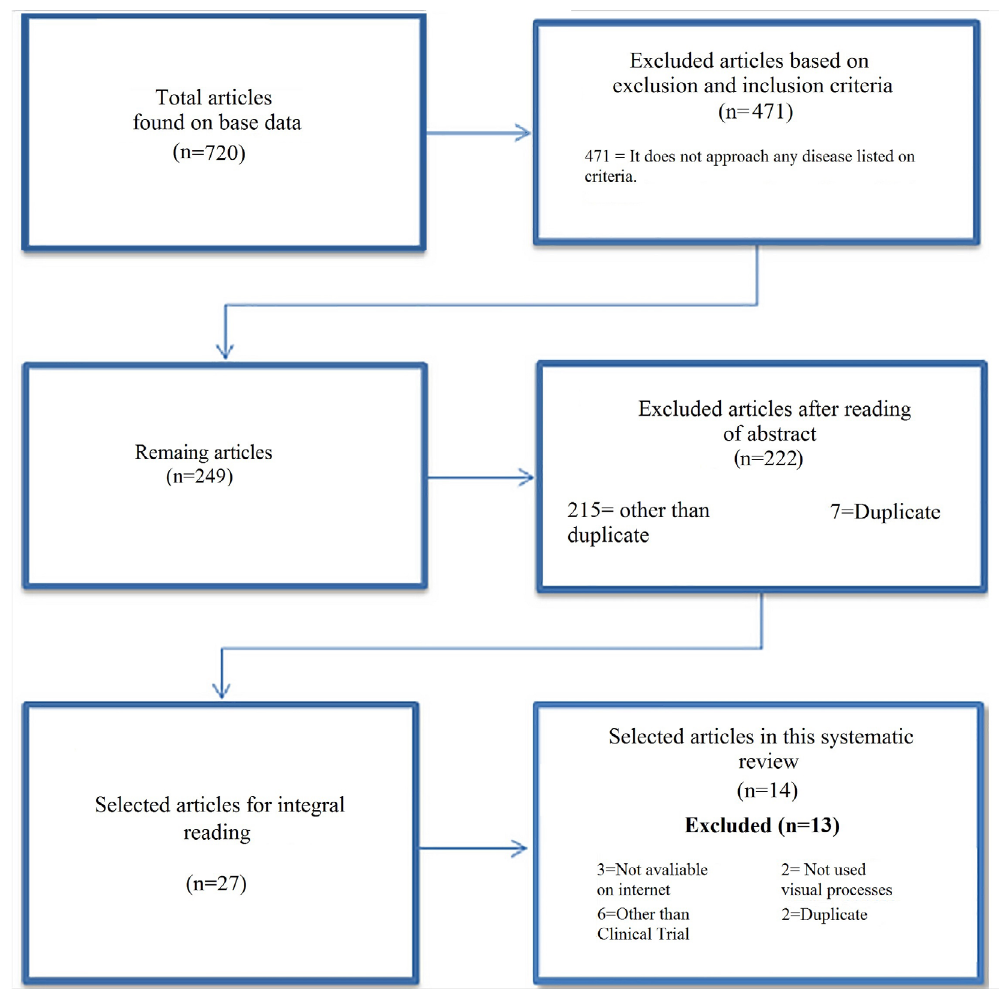
Figure 1. Flowchart of identified and selected studies based on database, criteria, and processes on